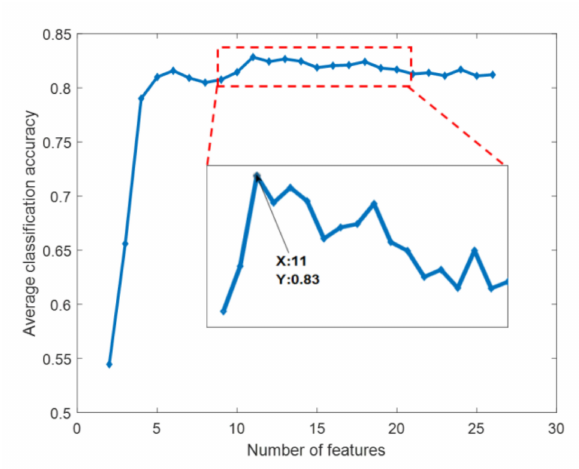
Figure 6. Average accuracy of the k -nearest neighbor ( K -NN) classifier based on features selected by genetic algorithm (GA) (std of 0.03–0.04).